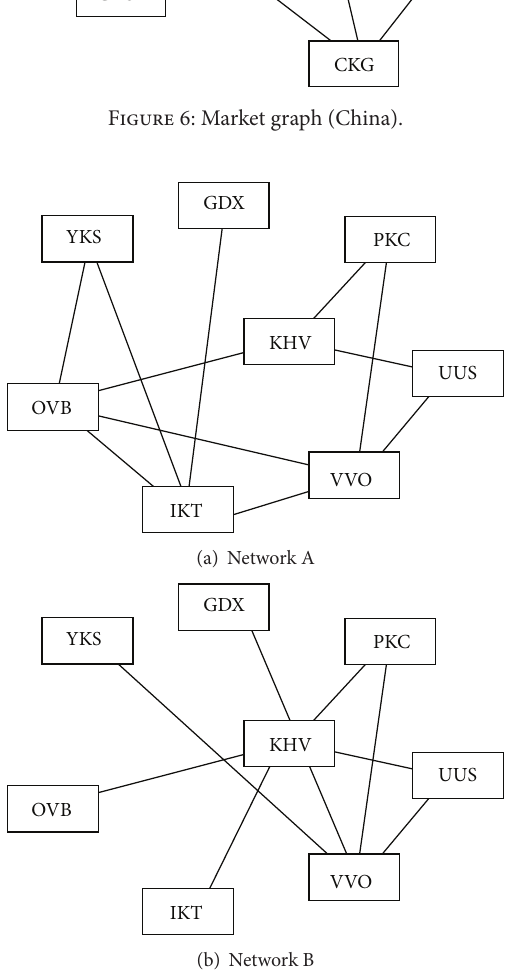
Figure 7: Operating networks (Russia).